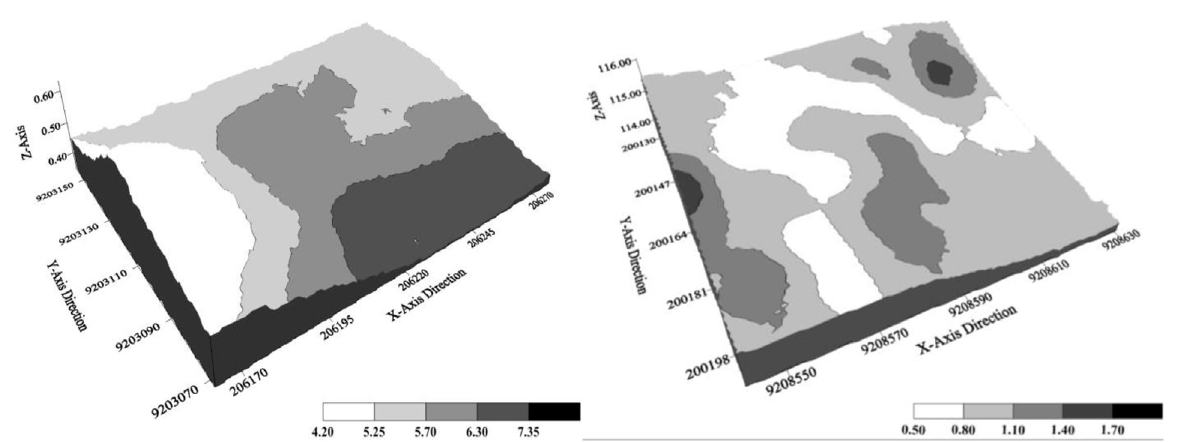
Figure 4. Magnetic Susceptibility kriging maps obtained by interpolation of the geostatistical parameters in IBEs under cultivation. Cocoa area (left) and Coffee cultivation area